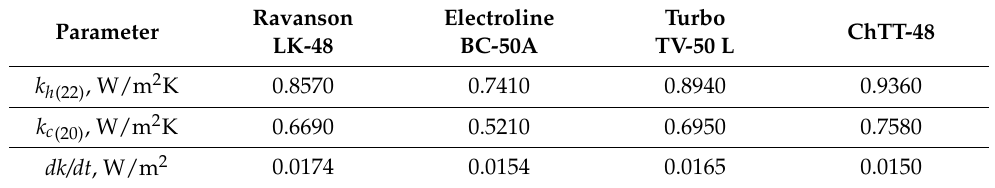
Figure 5. The values of the overall thermal transfer coefficient k of four refrigerators, calculated on the basis of the experiment data depending on the ambient temperature t a . Table 4. Results of determining the components and coefficients occurring in Equations (7) and